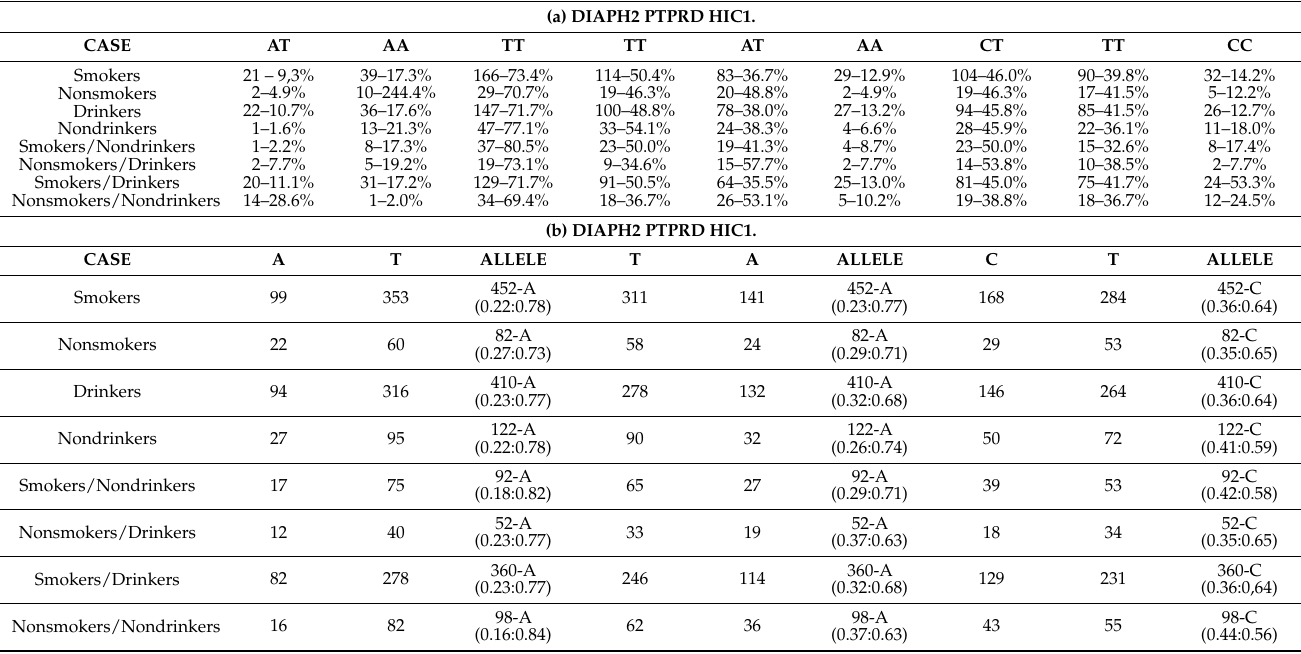
Table 4. Genotypes and alleles distribution in the case